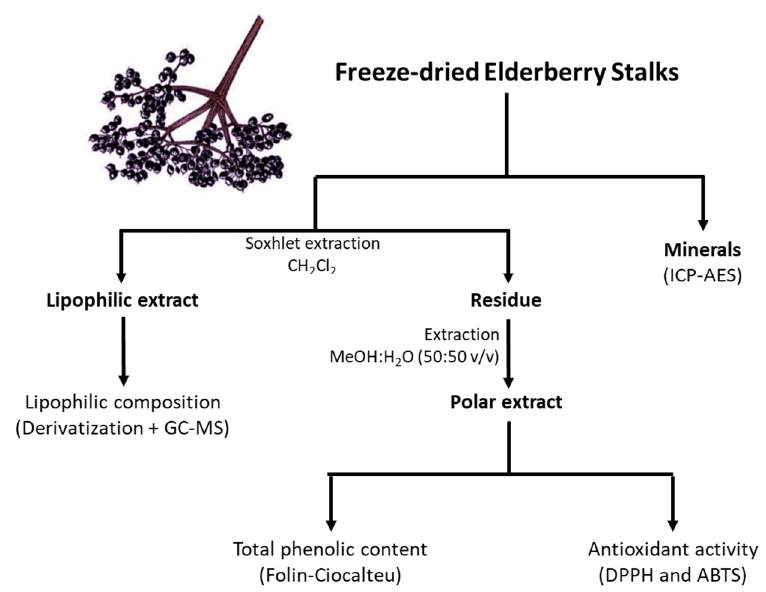
Figure 1. Scheme of the workflow followed in this work.